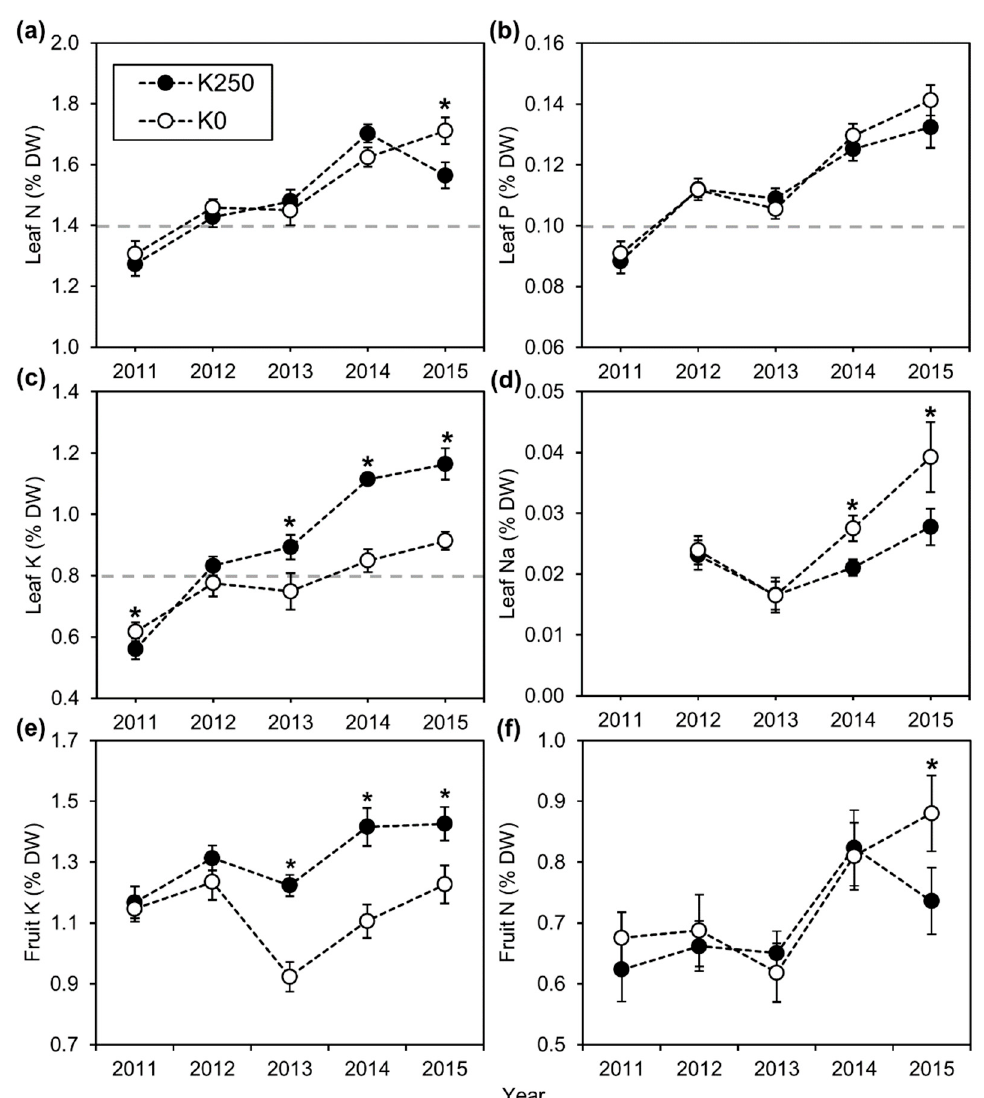
Figure 2. Influence of K fertilization on leaf and fruit mineral concentrations. Experimental plots were fertilized either with an annual amount of 250 kg K ha − 1 (K250) or without K (K0). Leaf N ( a ), P ( b ), K ( c ), and Na ( d ) concentrations were determined in diagnostic leaves sampled during July as percentage form dry weight (DW). Fruit K ( e ) and N ( f ) concentrations were determined in a sample of fruits at harvest. Numbers are mean values of 14 replicates (trees) ± standard error of the mean (bars). The dashed grey lines show the deficiency-sufficiency threshold for the specific mineral. Asterisks indicate significant statistical difference between K fertilization levels in the specified date according to Student’s t -test ( p ≤ 0.05). Values of leaf N for K250 were published previously [33].